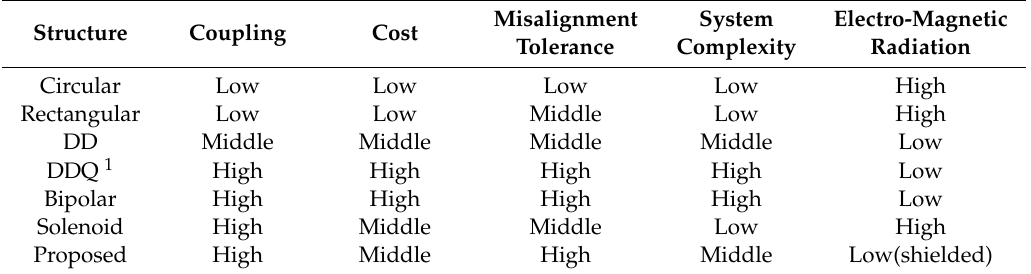
Table 1. Comparison with di ff erent coupling structures.